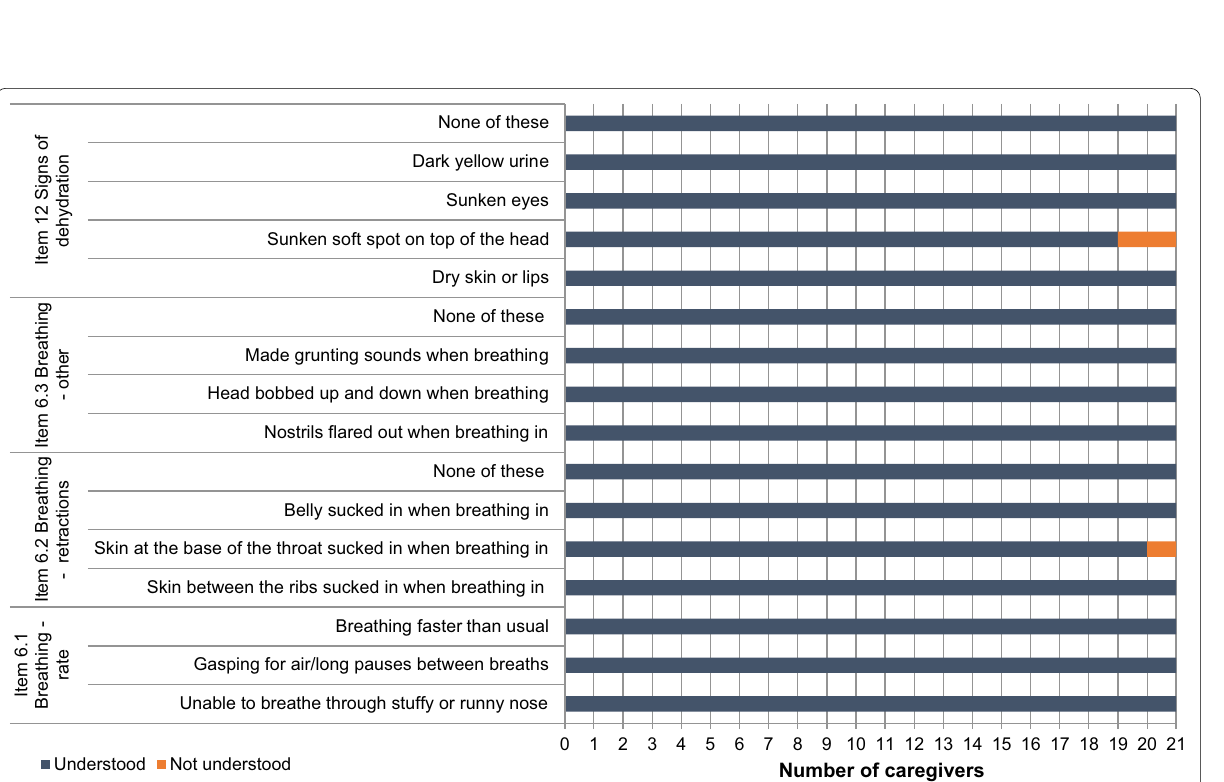
Fig. 3 Overview of participant understanding for PRESORS ObsRO v4.0 items 6.1, 6.2, 6.3 (‘Signs of breathing difficulties’) and item 12 (‘signs of dehydration’)